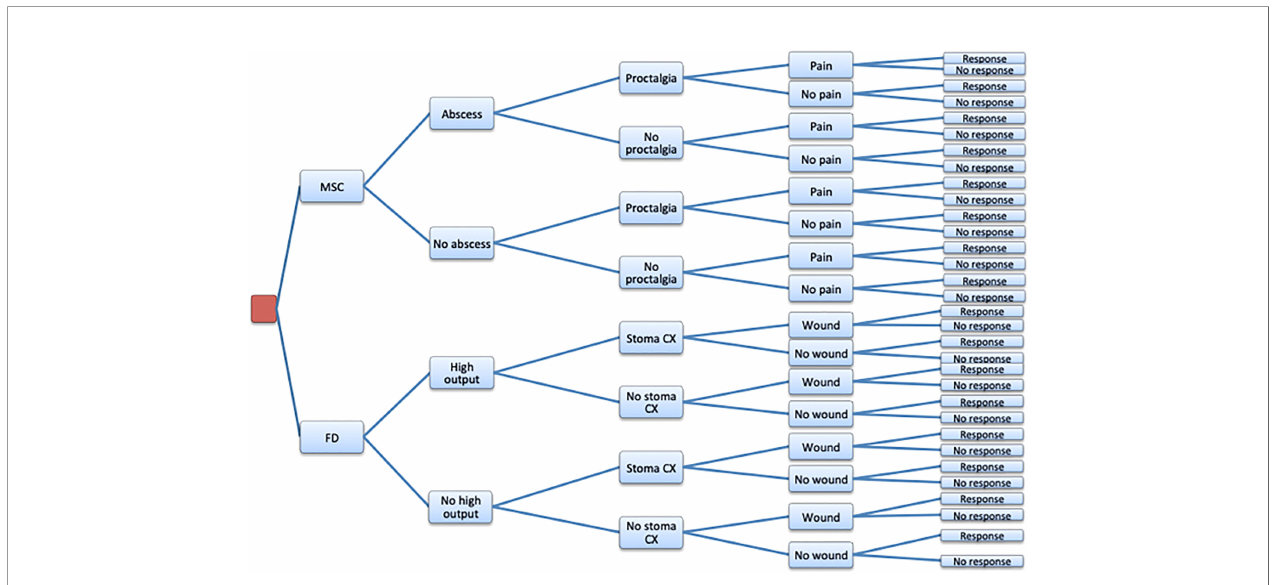
FIGURE 1 | Decision Tree Model. MSC, Mesenchymal stem cell theraphy; FD, Fecal Diversion; Abscess, Anal abscess; High output, Dehydration or renal failure from high ostomy output; Proctalgia, Protalgia; Pain, Procedural pain; Stoma CX, Stoma related compilations: parastomal hernia, retraction hernia, retraction, prolapse, obstruction; Wound, Peristomal skin related complications; Response, Clinical